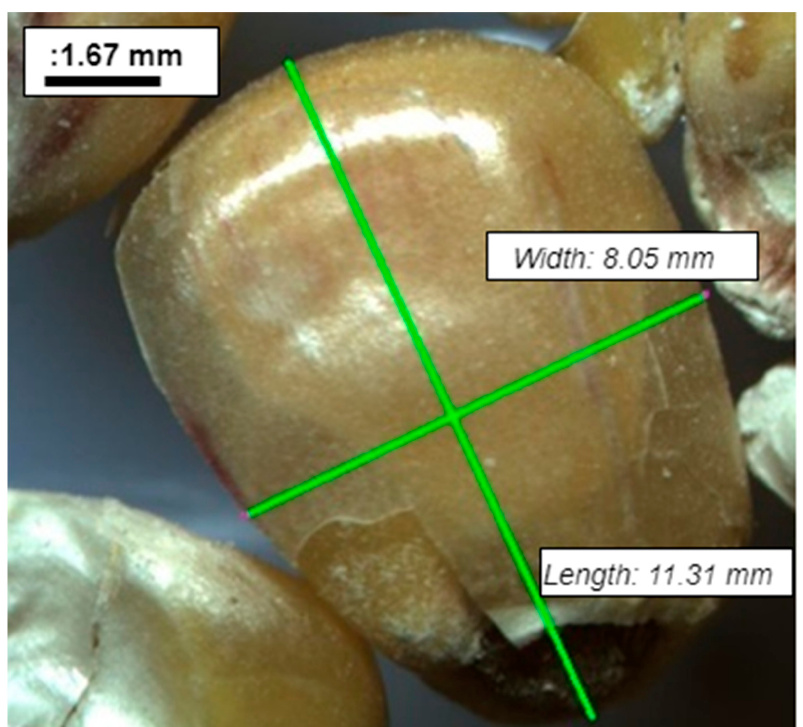
Figure A1. Sample photo showing the shape and size of corn grain of the studied variety. The photo was taken at a 15 times magnification. Table A1. Parameters of probability distributions for strength properties.